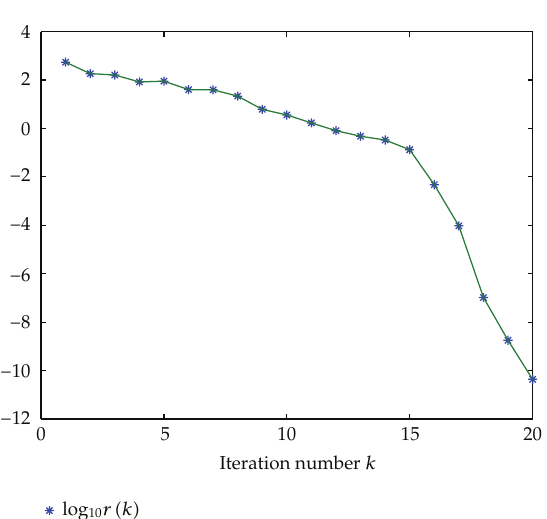
Figure 2: The convergence curve for the Frobenius norm of the residuals from Example